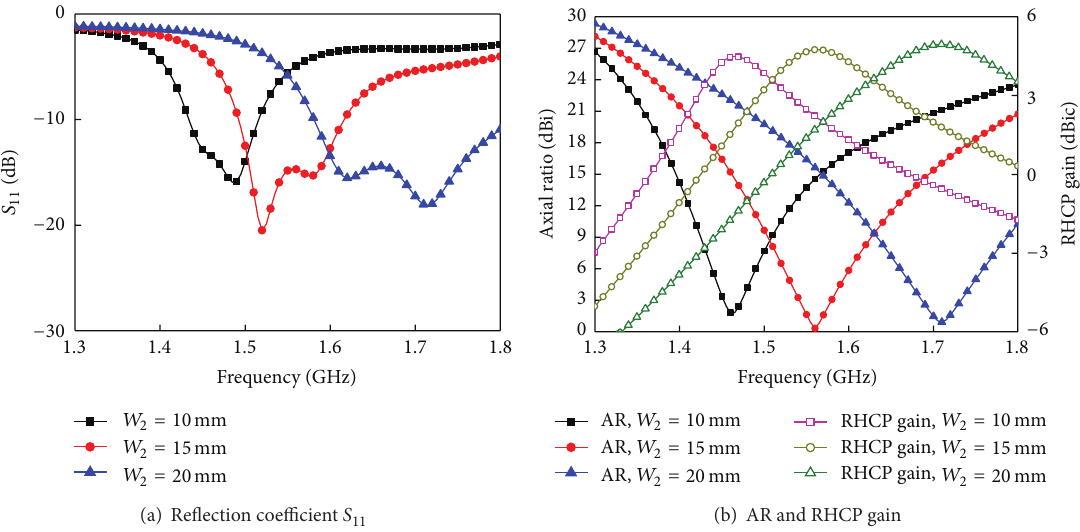
Figure 4: Effect of the top length 𝑊 2 of the trapezoid on the reflection coefficient, gain, and axial ratio of the antenna.